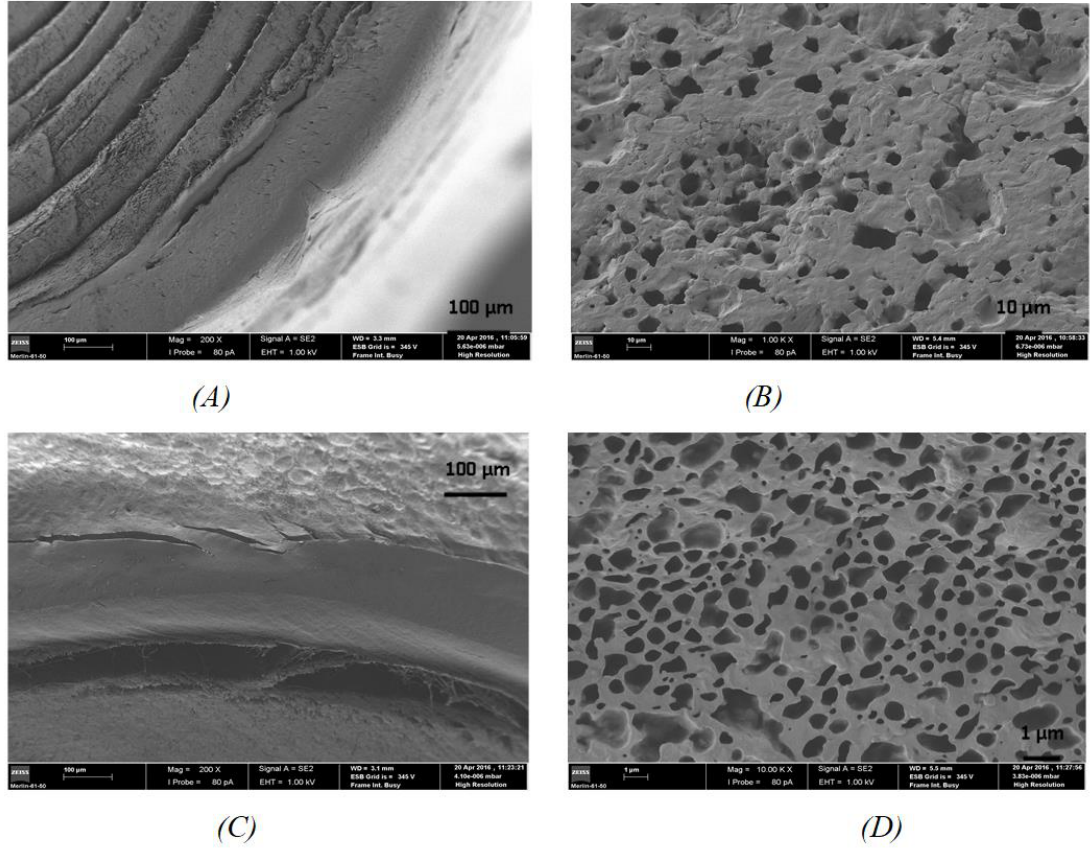
Figure 4. Images obtained by SEM. Cross section view ( A ) and coating surface ( B ) of the EDW 100 Lut implant and cross-section view ( C ) and coating surface ( D ) of the EDW 1000 Luw implant.